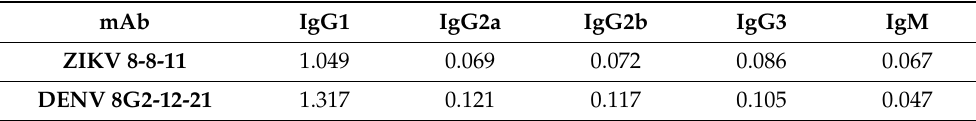
Table 1. Isotypes of ZIKV 8-8-11 and DENV 8G2-12-21 mAbs. mAb IgG1 IgG2a IgG2b